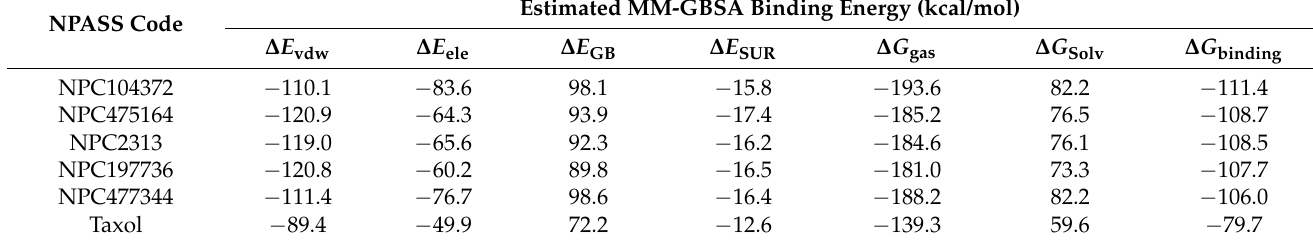
Table 2. Estimated MM-GBSA binding energies of NPC104372, NPC475164, NPC2313,